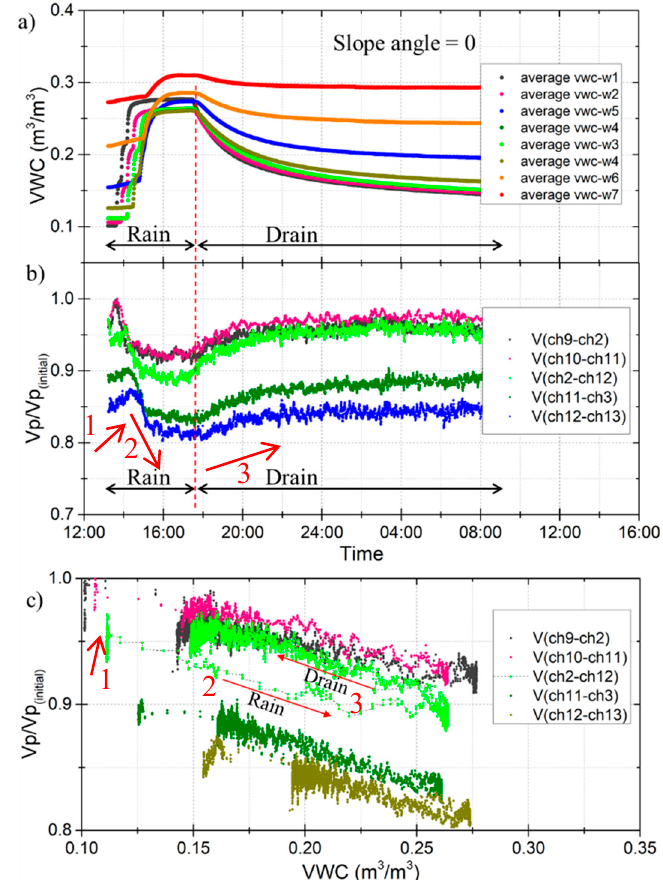
Figure 12. Response of elastic wave velocities at different VWC values during the rain and drain events (slope angle = 0); ( a ) average VWC versus time; ( b ) compression wave velocities (Vp/Vp (initial)) versus time; ( c ) compression wave velocities (Vp/Vp (initial)) versus the VWC.